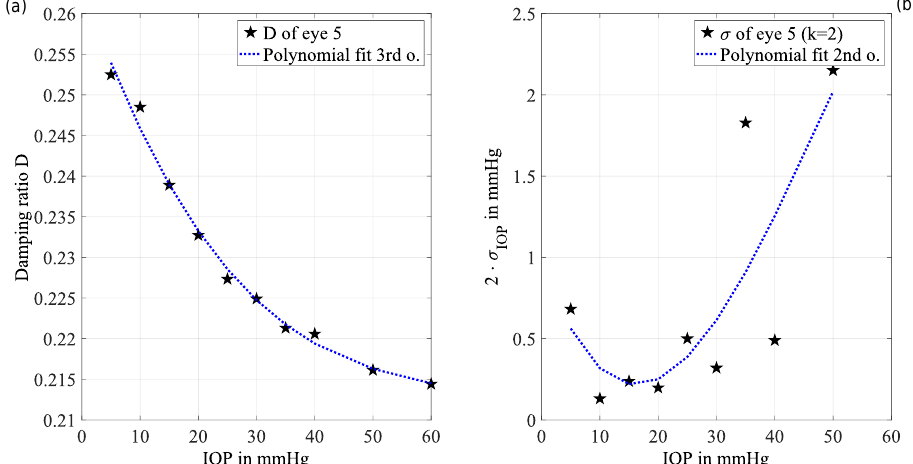
Figure 5. (a) The damping ratio calculated with formulae (4) and (5) is plotted against the IOP level. The sensitivity is represented by the slope of the curve which has the largest absolute value between 10 and 35mmHg. For higher IOP levels the absolute value of the slope decreases, which shows a lower sensitivity. The curve is fitted by a third-order polynomial ( R 2 = 0 . 992) for the error propagation calculation. (b) The derived standard uncertainty of the IOP determination with a coverage factor k = 2 is plotted against the IOP. In the range from 5 to 35mmHg, the estimated standard uncertainty of the mean is below 1mmHg. This confirms the feasibility of the measurement principle for clinical